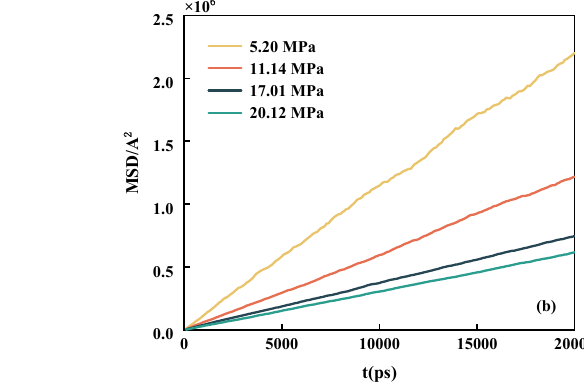
Figure 10. MSD of n-decane/CH 4 at different pressures at 313.3 K. ( a ) N-decane; ( b ) CH 4 .